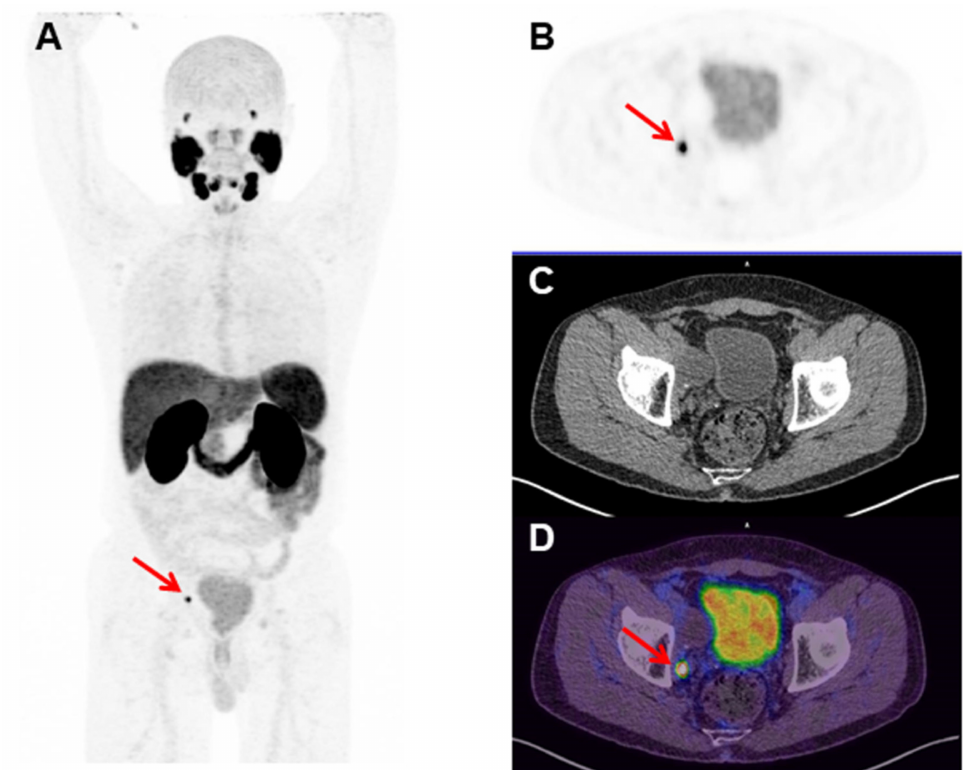
Figure 5. [ 68 Ga]Ga-PSMA-11 Positron Emission Tomography (PET) images of a 68 year old man with a Gleason score of 8 (4 + 4), prostate cancer (PCa), and a serum prostate-specific antigen (PSA) of 0.15 ng/mL, who was treated with initial radical prostatectomy four months before the present exam. (A) The maximum intensity projection (MIP), (B) axial PET, (C) Computed Tomography (CT), and (D) fused PET/CT images of the pelvis show a small (6 mm) [ 68 Ga]Ga-PSMA-11 PET-positive right obturator lymph node (red arrows) (Nuclear Medicine Department, Hospital Israelita Albert Einstein, Sao Paulo,